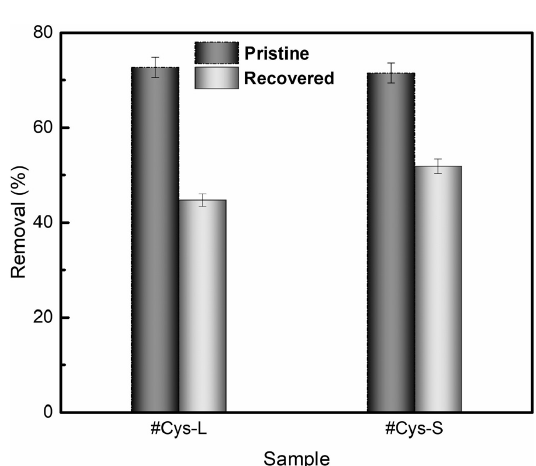
Figure 10. Comparative of removal percentage of pristine and recovered